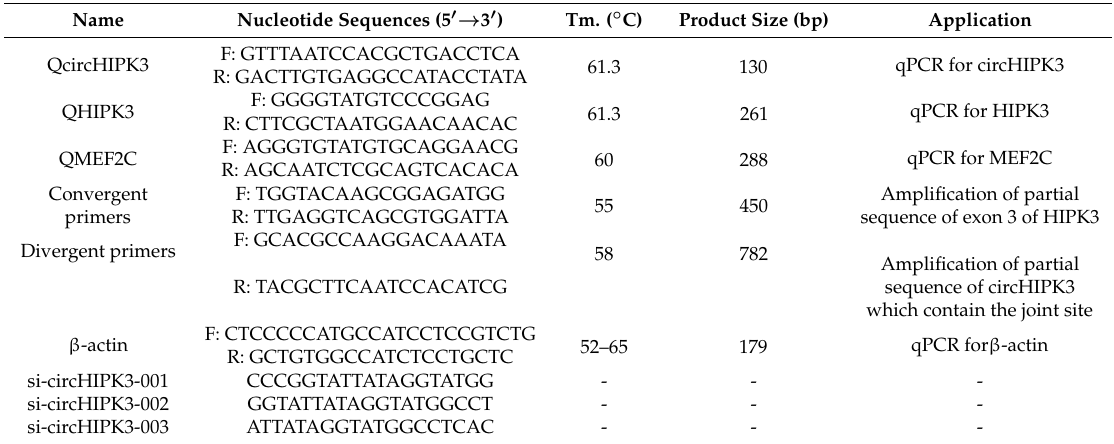
Table 1. Primers and RNA oligos used in this